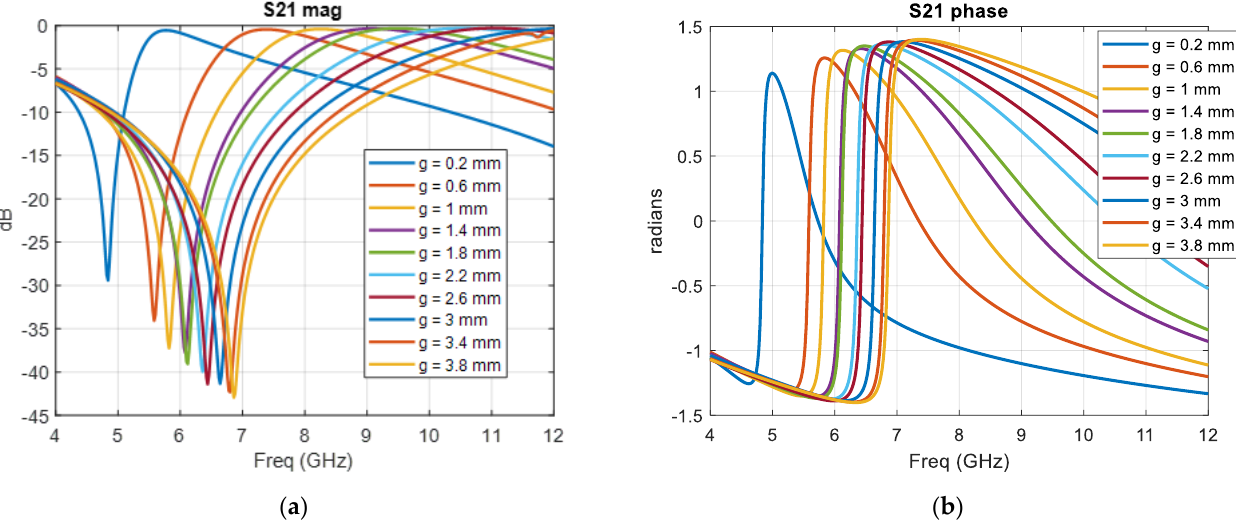
Figure 4. HFSS Parametric simulation results ( a ) S 21 magnitude ( b ) S 21 phase.